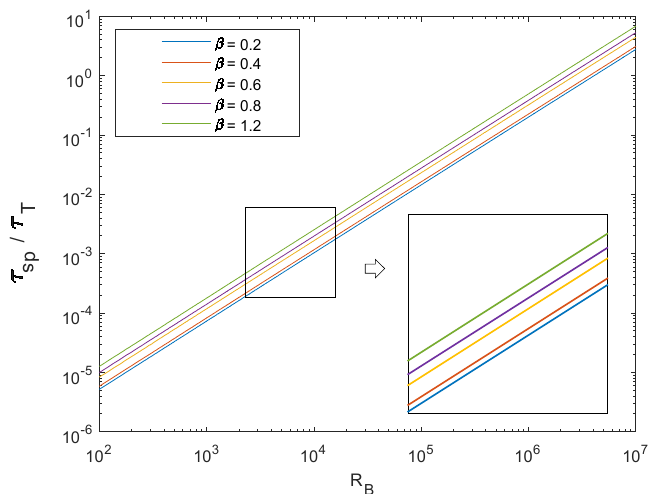
Figure 4. Variations of the sea spray droplet momentum flux to the total momentum flux ratio, as a function of R B under different wave ages.